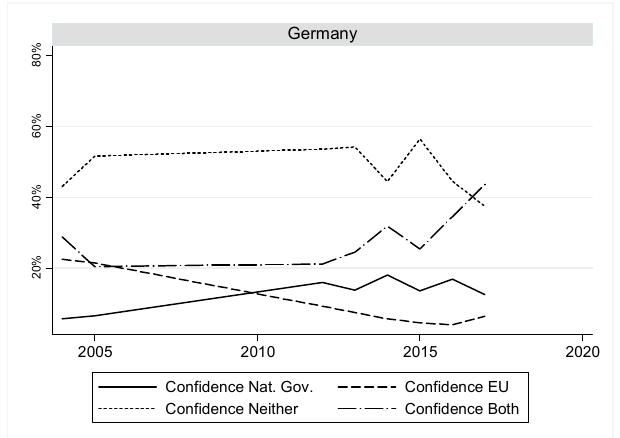
Figure 3. Evolution of the confidence differential in the national government, the EU, in both, and in neither, in Germany (2004–2017) Source: Own elaboration from Eurobarometer Note: Column percentage of differential confidence (variable created taking into account confidence in national government and confidence in EU).